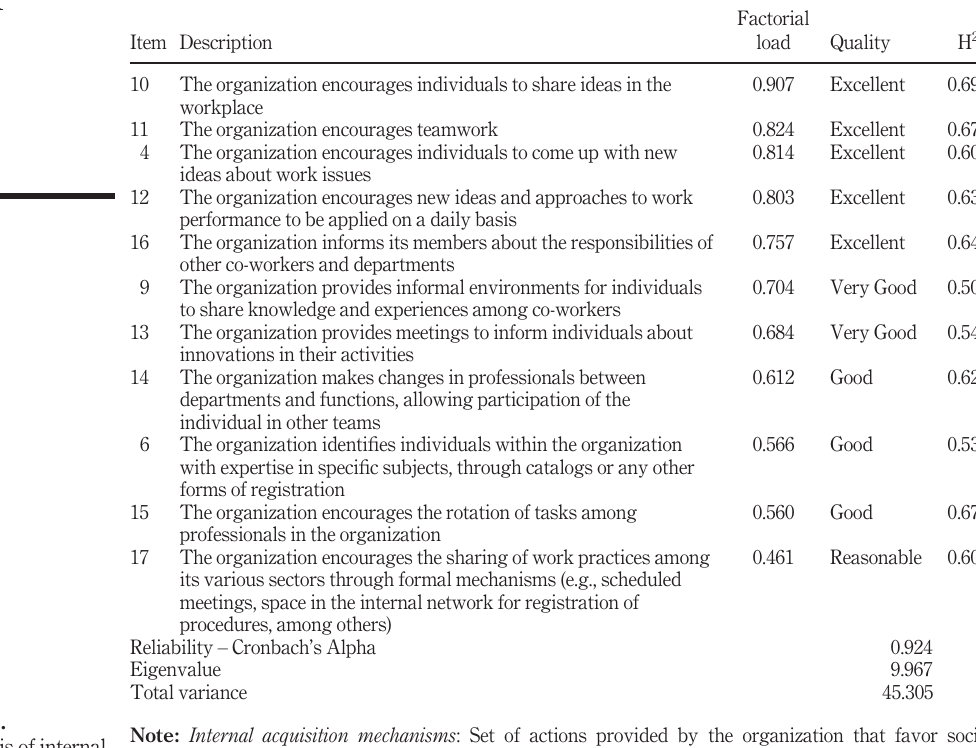
Table I. Synthesis of internal acquisition